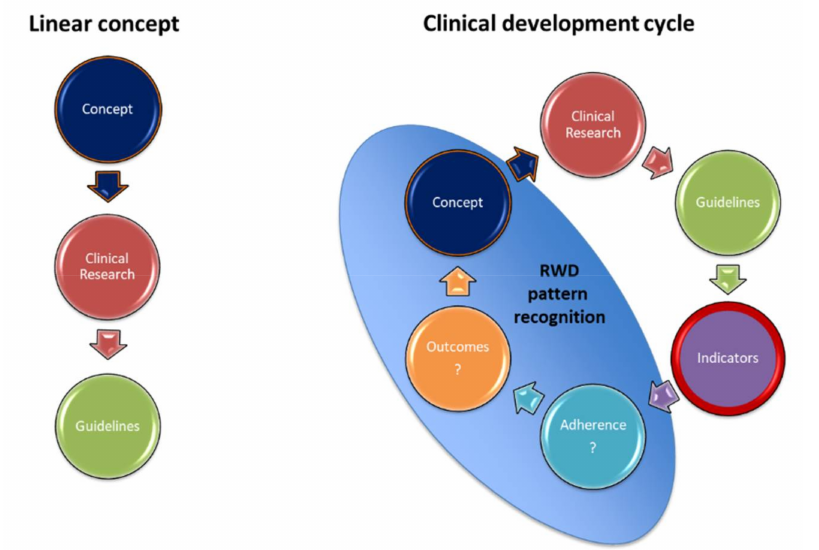
Figure 5. Clinical development cycles. RWD: Real-world data. Currently, clinical